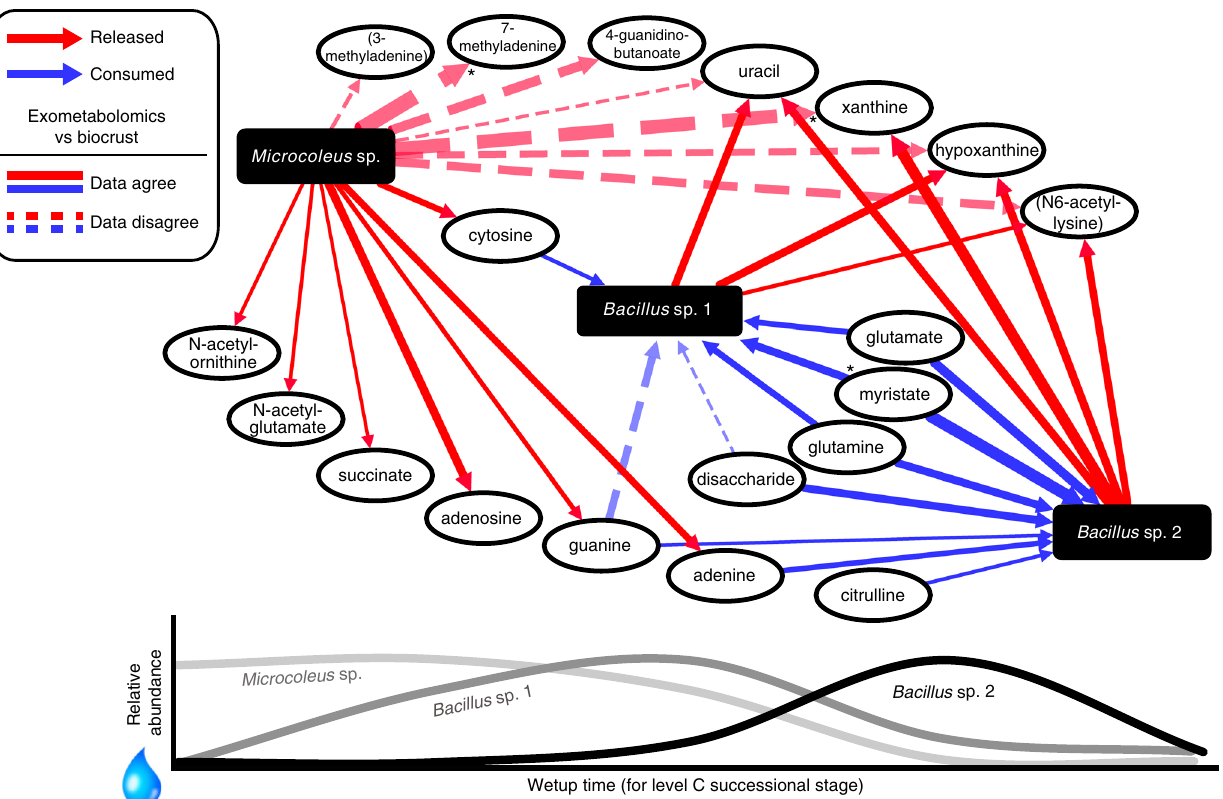
Fig. 3 Simpli fi ed biocrust foodweb for three dominant biocrust bacteria based on combining isolate exometabolomics data with in situ microbe – metabolite relationships. This network displays the relationships between metabolites and three dominant bacteria (or metabolically similar organisms) as they increase and decrease in relative abundance across wetting and successional stages in biocrust. The lower line plot corresponds to real relative abundance measurements for the three bacteria in level C successional stage biocrust. As Microcoleus sp. increases in relative abundance immediately after wetting, many metabolites released by the closest-related isolate are positively correlated with Microcoleus sp. in biocrust (solid red arrows) and as the two Bacilli increase in relative abundance ( fi rst Bacillus sp. 1 then Bacillus sp. 2), most metabolites consumed by the closest-related isolate decrease and are negatively correlated with these bacteria in biocrust (solid blue arrows) and most released metabolites are positively correlated (solid red arrows). Dotted arrows indicate metabolites that are released (red) or consumed (blue) by isolates, but did not display the expected relationship with that microorganism in situ. The thickness of the line corresponds to the absolute value of the Spearman ’ s rho correlation coef fi cient. The overall expected directionality (solid lines vs. dotted lines) was signi fi cant as determined by the exact binomial test (two-tailed p -value = 0.01). *FDR-adjusted p < 0.05 for individual